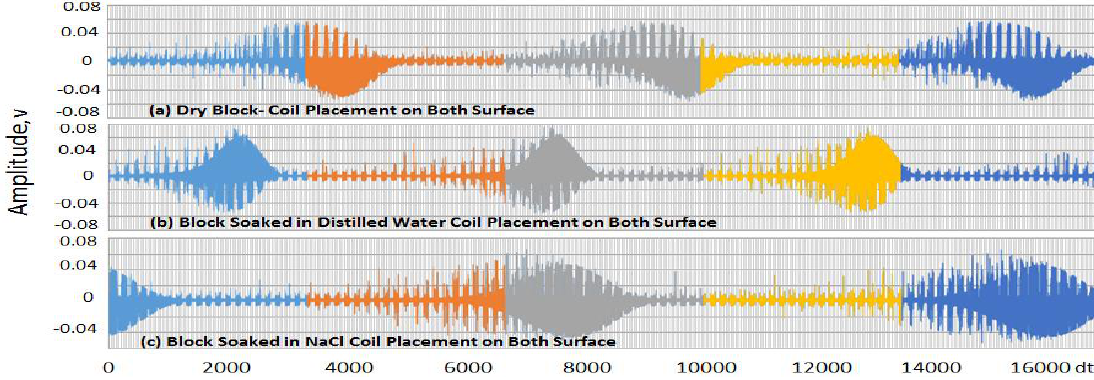
Figure 7. Voltages obtained from tests conducted with coils placed on opposite sides on ( a ) dry concrete